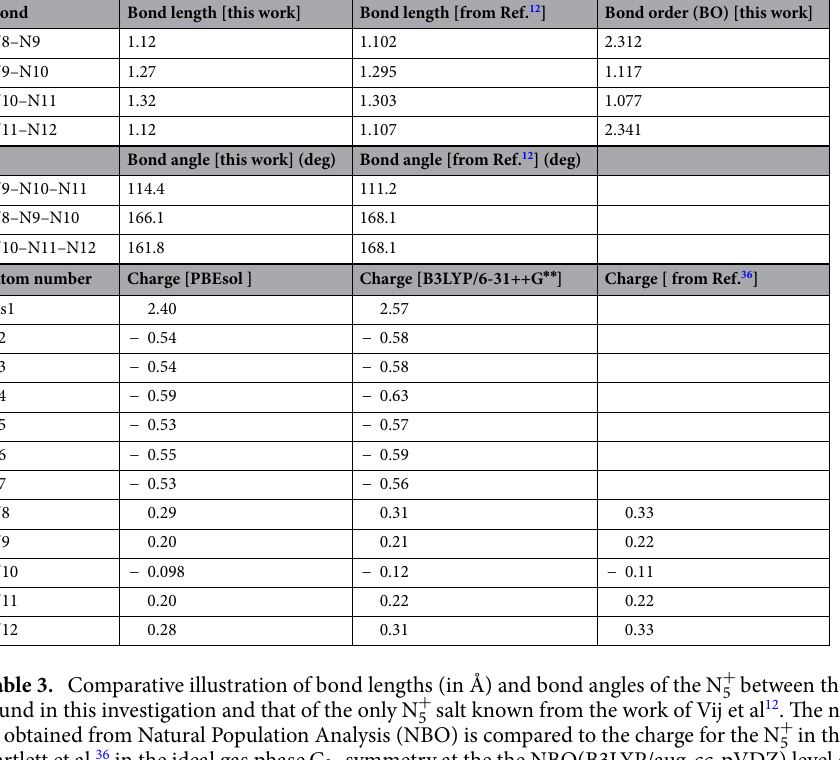
Table 3. Comparative illustration of bond lengths (in Å) and bond angles of the N found in this investigation and that of the only N as obtained from Natural Population Analysis (NBO) is compared to the charge for the N Bartlett et al. 36 in the ideal gas phase C 2 v symmetry at the the NBO(B3LYP/aug-cc-pVDZ) level of theory 36 .